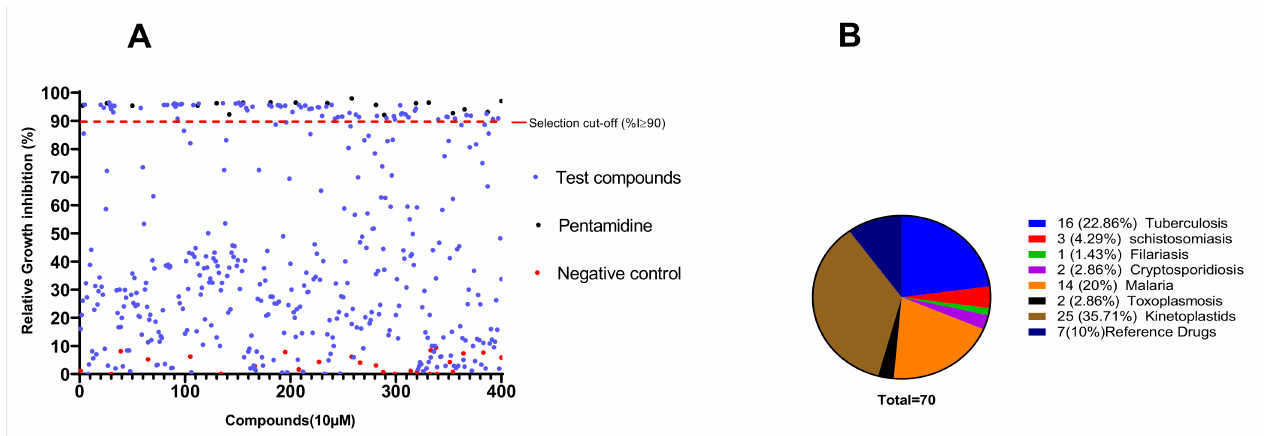
Figure 1. Antitrypanosomal activity cutoff of the 400 MMVPB compounds. ( A ) Compounds were screened at 10 µ M using the resazurin assay, and inhibition percentages were determined relative to the negative control culture. The 90% cutoff criterion (red dotted line) was used to select the most promising inhibitors for concentration–response assays. ( B ) Pie chart showing the distribution of selected inhibitors according to their reported disease